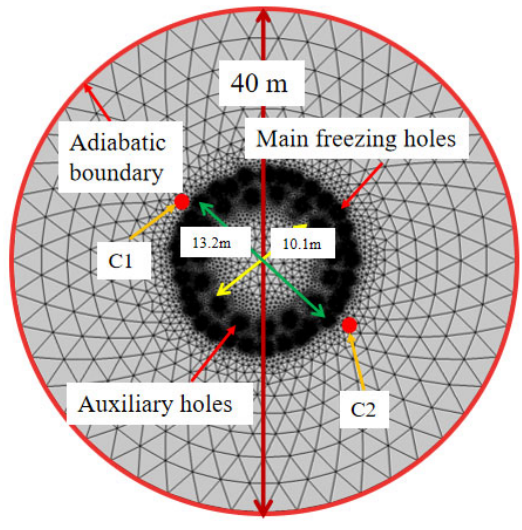
Figure 2. Numerical calculation model for − 216 m sandy clay layer.